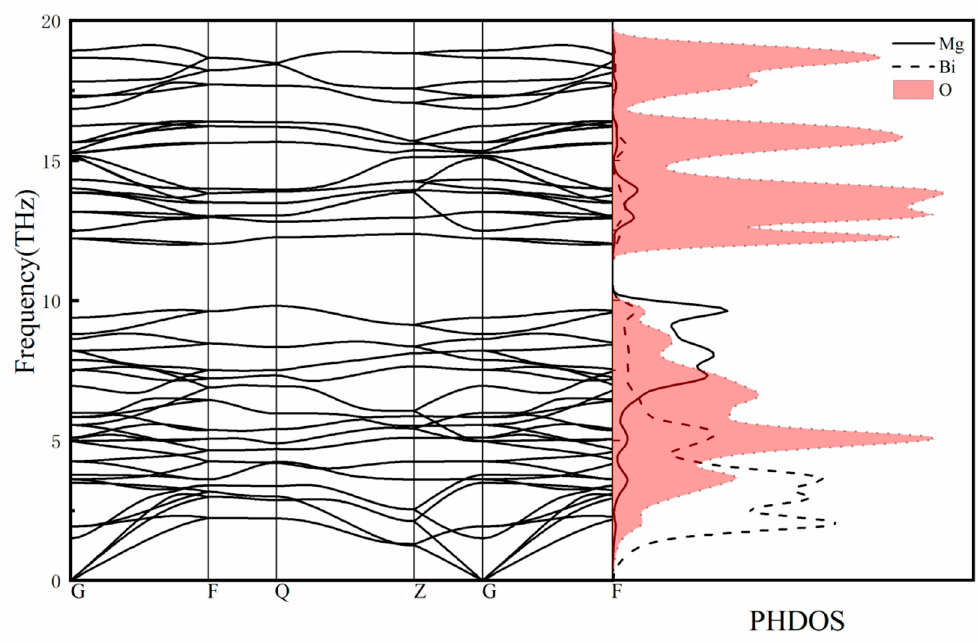
Figure 8. Calculated phonon dispersion curves and phonon density of states of MgBi 2 O 6 .